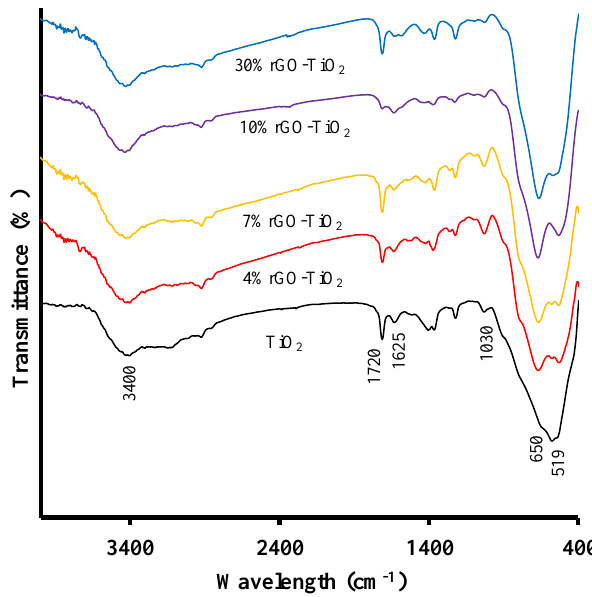
Figure 5. FTIR spectra of TiO 2 and rGO-TiO 2 composites.